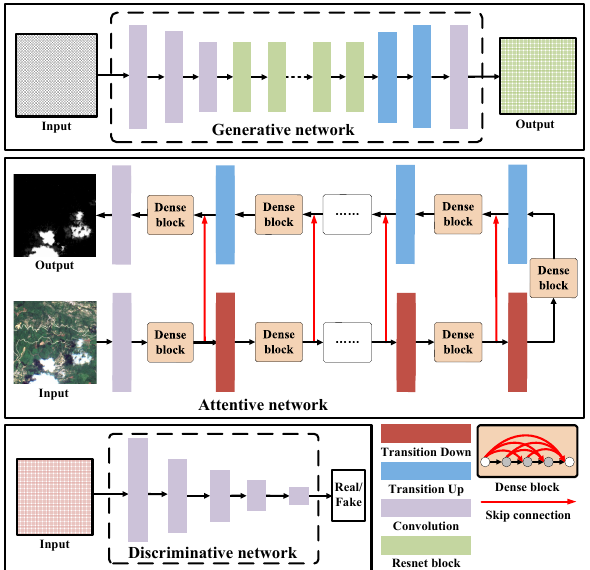
Figure 2. Detail components of generative network, attentive network and discriminative network.